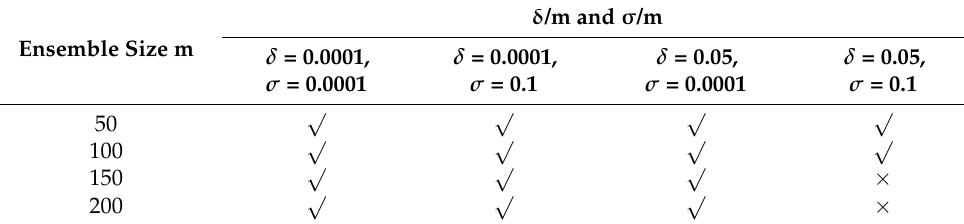
Table 2. Combination of ensemble size, standard deviation, and observation noise level.